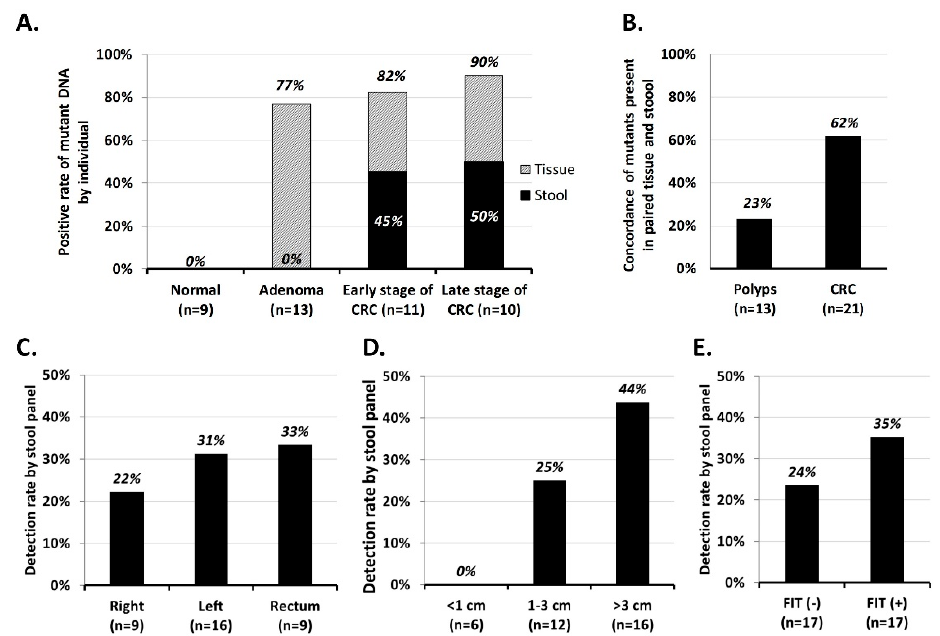
Figure 3. Correlation of the mutant detection rate of the sDNA test and various clinicopathological factors in cohort